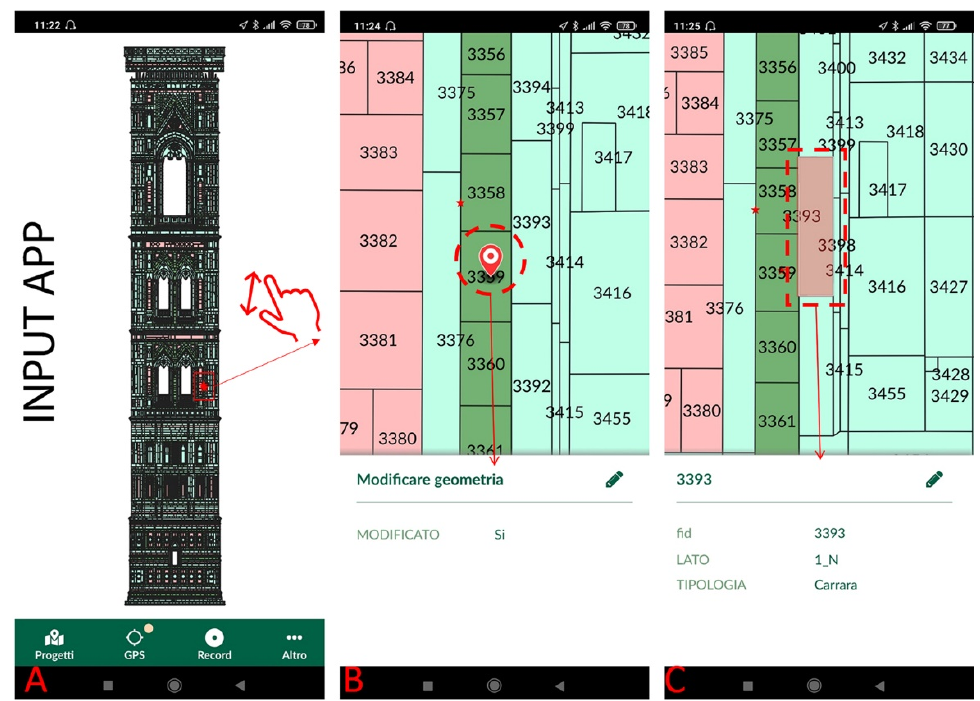
Figure 7. Field mobile survey activity sample. Screenshot ( A )—complete view of the themed levels. Screenshot ( B )—After zooming in the area of interest, in the example, a point is added on service layer to indicate the necessary geometric modification. Screenshot ( C )—by tapping on screen is possible to identify the base element ("lastra" in this case) or edit the lithology attribution.